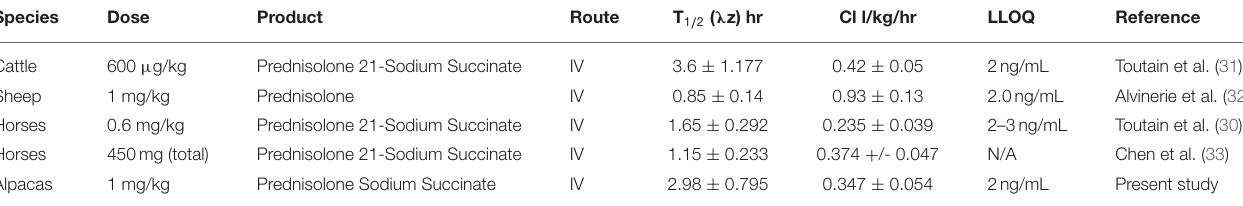
TABLE 2 | Comparative pharmacokinetic parameters for prednisolone in other large animal species. Species